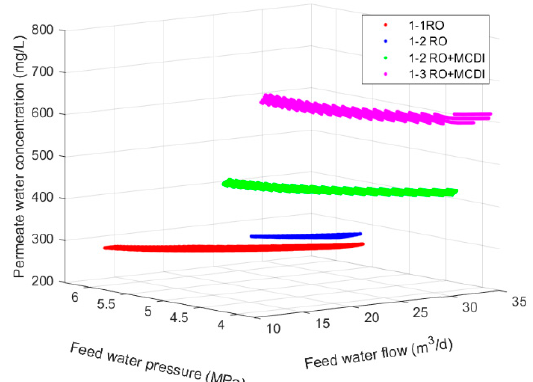
Figure 6. Relationship among feed water pressure, feed water flow rate and water recovery rate of RO under constraint condition of water production.